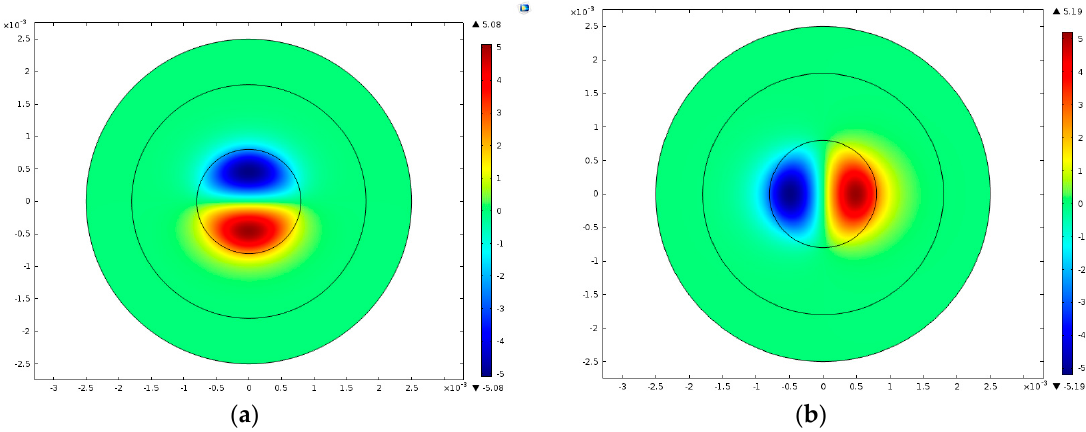
7 1.606981 10 Hz f